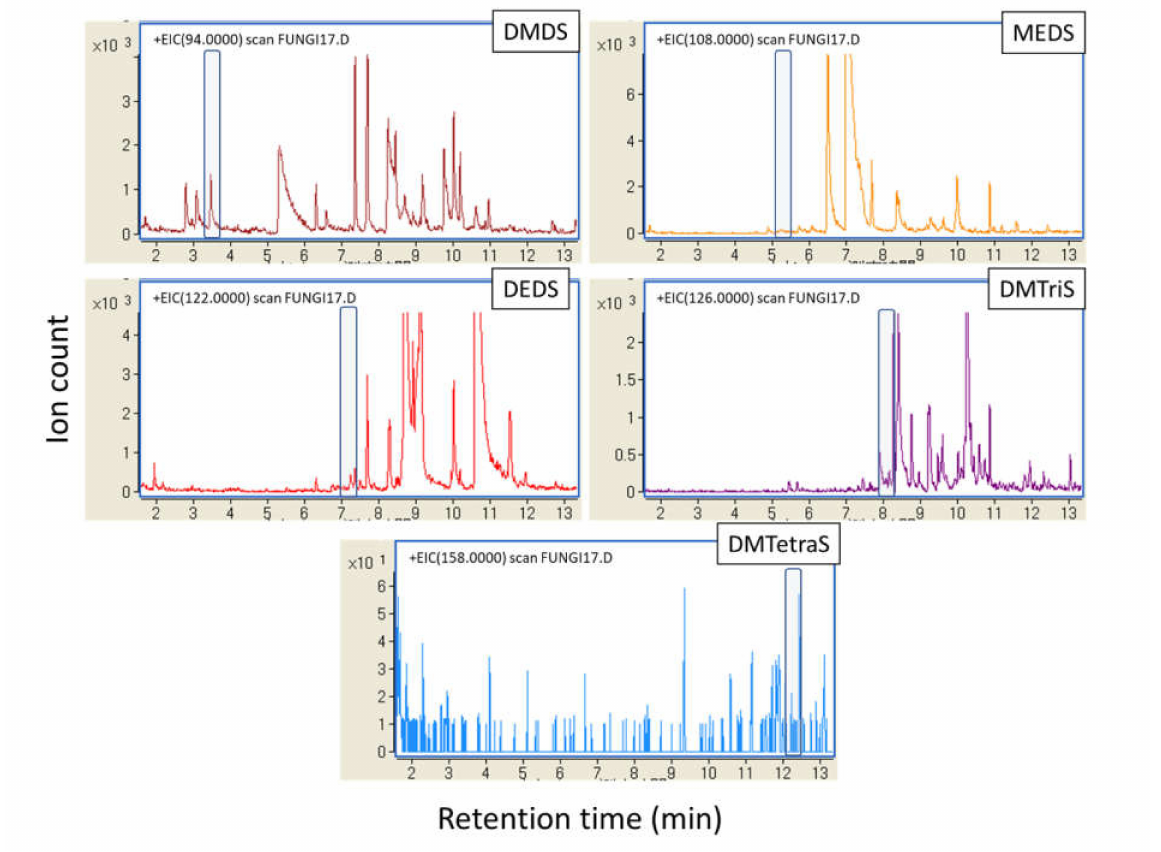
Figure 3. Extracted-ion chromatograms of VOCs from A. fumigatus IFM 51748. The gray-shaded area shows the putative retention time of each polysulfide.